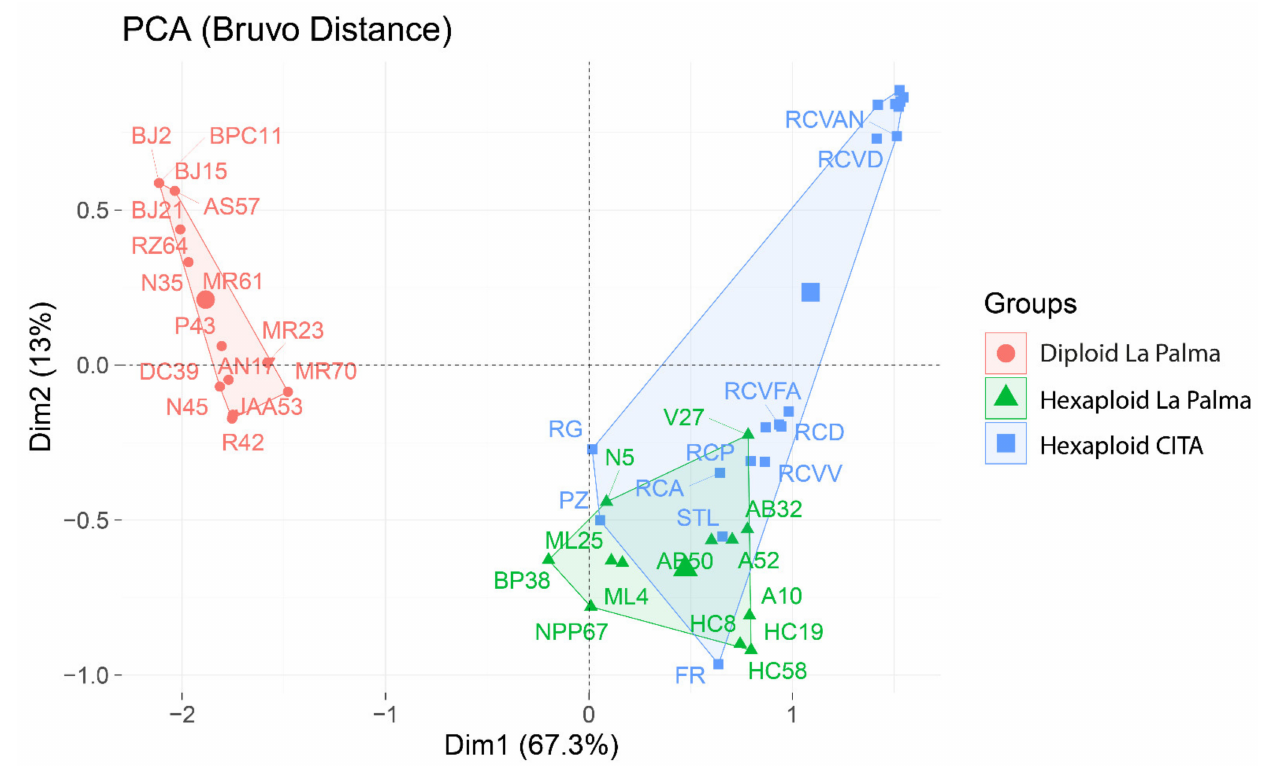
Figure 2. PCA based on Bruvo pairwise distance matrix. Diploid species (diploid LP plums) are in red. Hexaploid species of Prunus domestica are in green (hexaploid LP plums) and blue (hexaploid CITA plums). Accessions correspond to abbreviations in Table